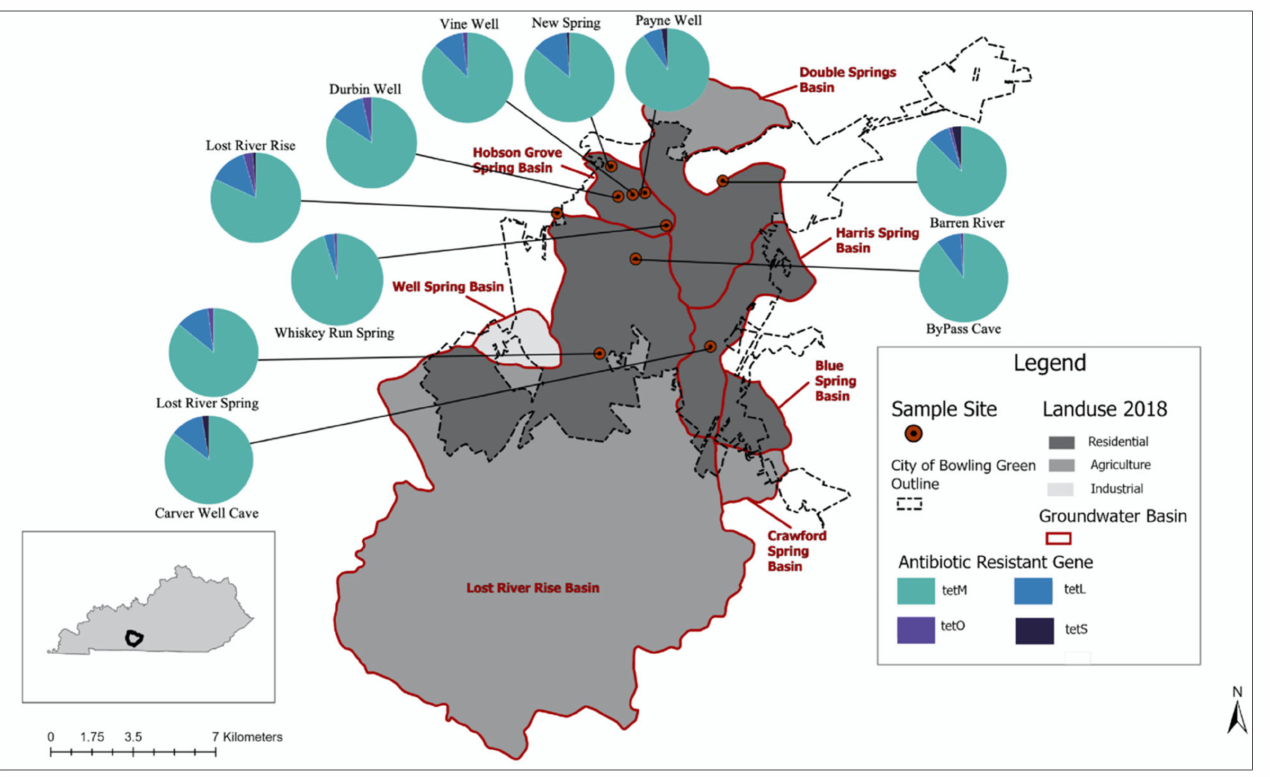
Figure 6. Spatially represented tetracycline ARG detection frequency associated with resistance phenotypes for Enterococcus spp. and landuse in Bowling Green, KY urban karst